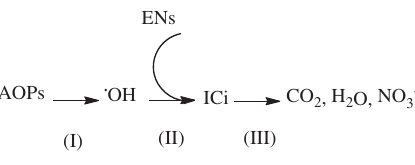
) vs. time in different systems. o